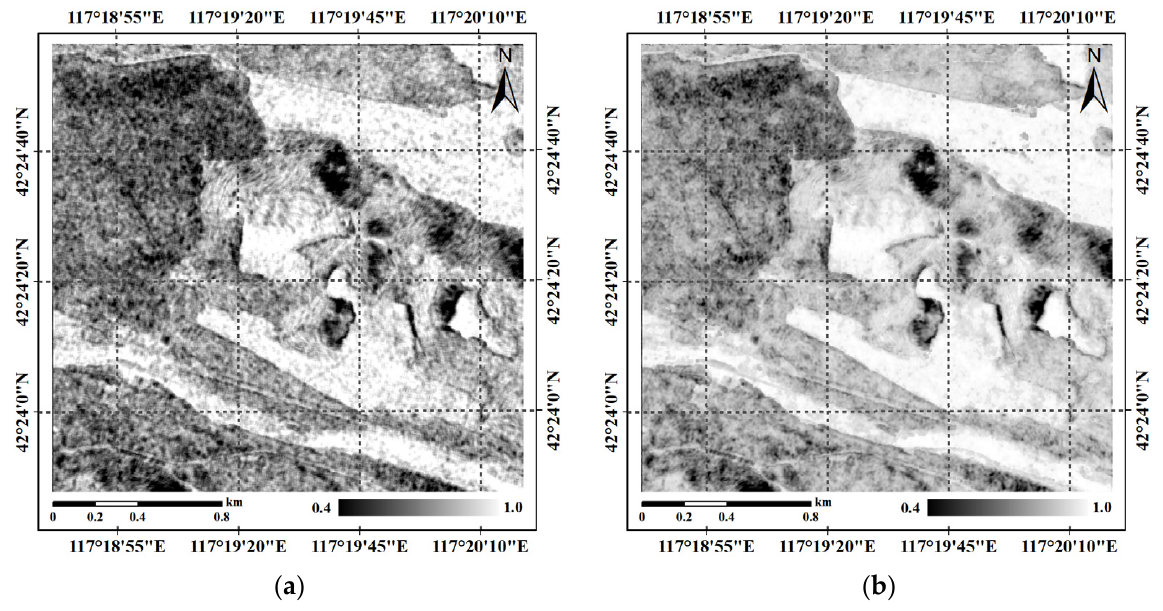
Figure 11. The calculation results of coherence for different compensation methods: ( a ) Calculation result of coherence for IDUV; ( b ) Calculation result of coherence for MLM.